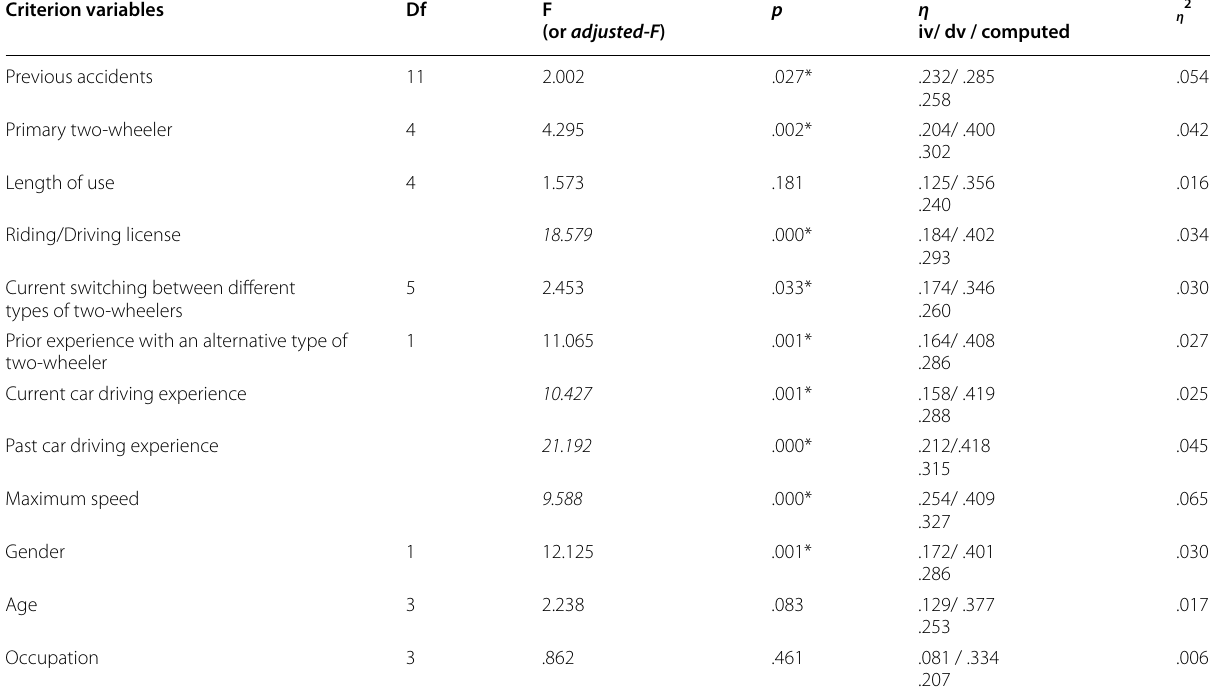
Table 4 F‑ratio (or adjusted F‑ratio), significance, eta (η) correlation ratio, and effect size (η 2 ) of A‑TRIBE inventory with criterion variables (N =